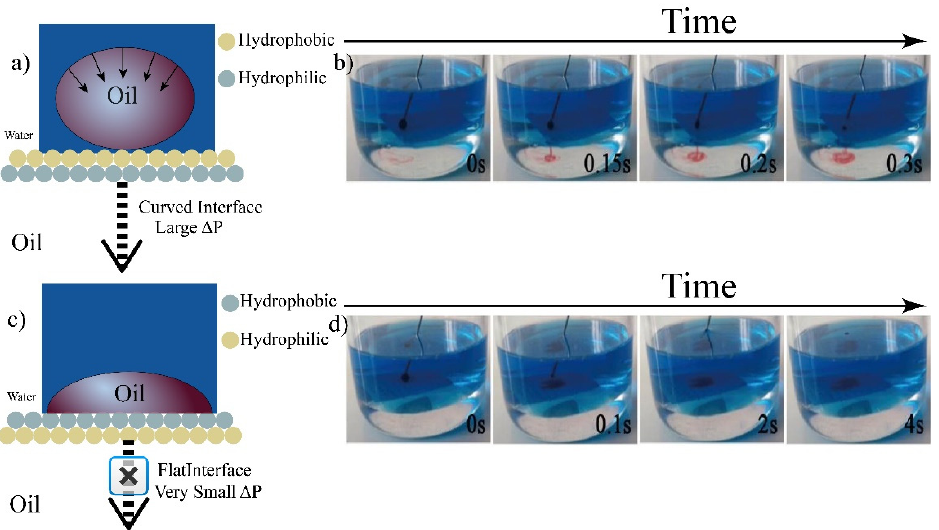
Figure 9 . Unidirectional oil droplet penetration across Janus paper (300 μ m) in the water–oil system. ( a , b ) For negatively aligned Janus paper, an oil droplet (carbon tetrachloride) touching the superhydrophilic (oleophobic underwater) side exerts a larger P L , creating a larger driving force for penetration. ( c , d ) For positively aligned Janus paper, an oil droplet seated on the hydrophobic (oleophilic underwater) side tends to spread, exerting a smaller P L